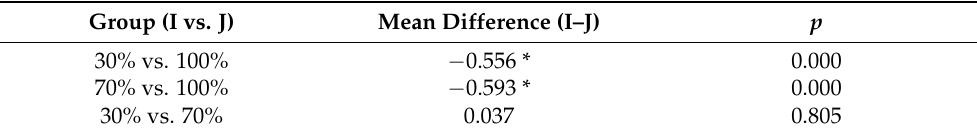
Table 19. Post-hoc (LSD) multiple factors comparison analysis of impacts of different edge perme- ability levels on perceived depression.